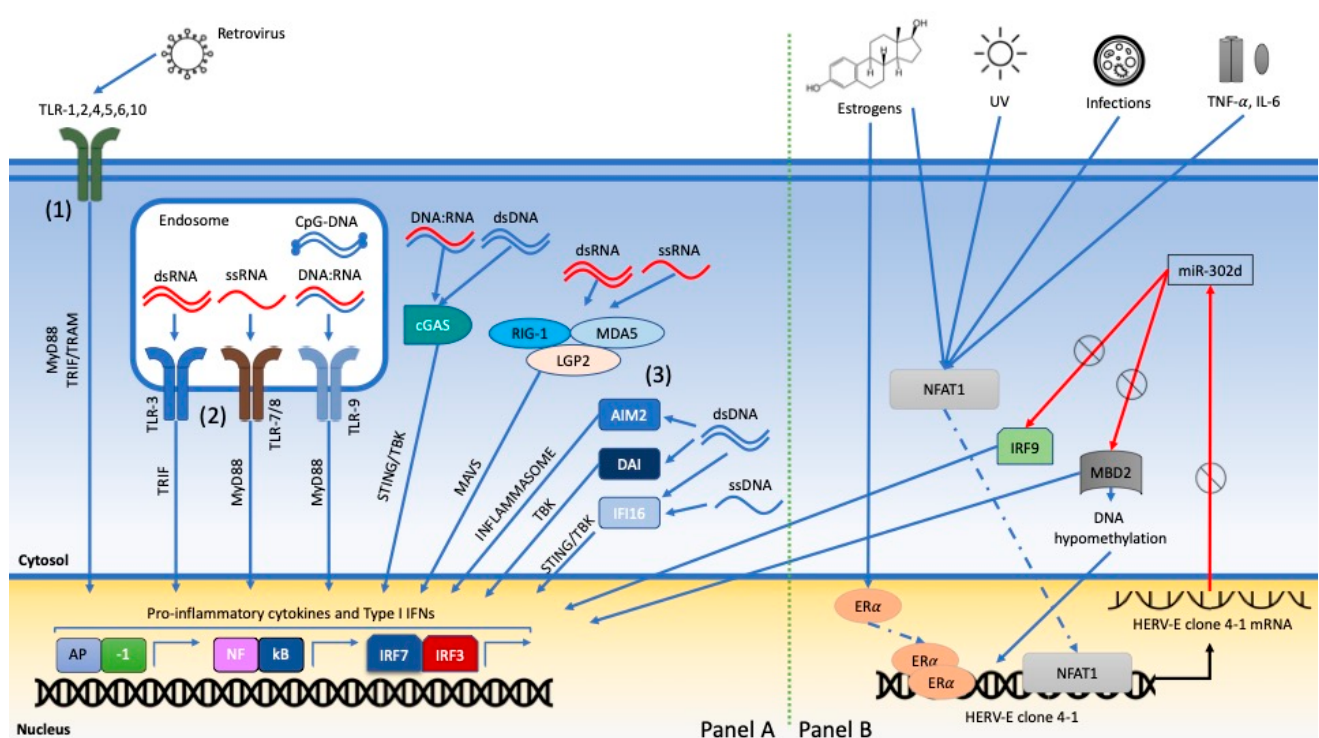
Figure 2. Human Exogenous and Endogenous RVs initiate proinflammatory intracellular pathways converging on critical immune genes involved in SLE pathogenesis. Exogenous RVs RNA and retrotranscribed DNA can activate different cellular sensors located at plasmatic (1) and endosomal membranes (2) or in the cytosol (3), triggering a proinflammatory response (Panel A). HERVs similarly activate endosomal TLRs and also mediate the effects of environmental factors on critical immune genes: estrogens, UVB and infections can increase HERV-E clone 4-1 mRNA expression in SLE CD4+ T-cells and PBMCs, activating a cascade which leads to DNA hypomethylation and type I IFN response (Panel B). Legend: MyD88: Myeloid differentiation primary response 88, TRIF: TIR-domain-containing adapter-inducing interferon- β , TRAM: TRIF-related adaptor molecule, AP-1: activator protein-1, cGAS: cyclic GMP-AMP synthase, cGAMP: cyclic guanosine monophosphate- adenosine monophosphate, STING: cyclic GMP-AMP receptor stimulator of interferon genes, TBK: TANK-binding kinase, IRF: interferon regulator factor, RIG-1: retinoic acid-inducible gene 1, MDA5: melanoma differentiation-associated protein-5, AIM2: absent in melanoma 2, DAI: DNA-dependent activator of interferon regulatory factor, IFI16: γ -interferon-inducible protein IFI-16, MAVS: mitochondrial antiviral signaling protein, LGP2: the laboratory of genetics and physiology 2, NFAT1: nuclear factor of activated T cells 1, MBD2: methyl-CpG-binding domain protein 2,UVB: ultraviolet beams, ER α : estrogen receptor